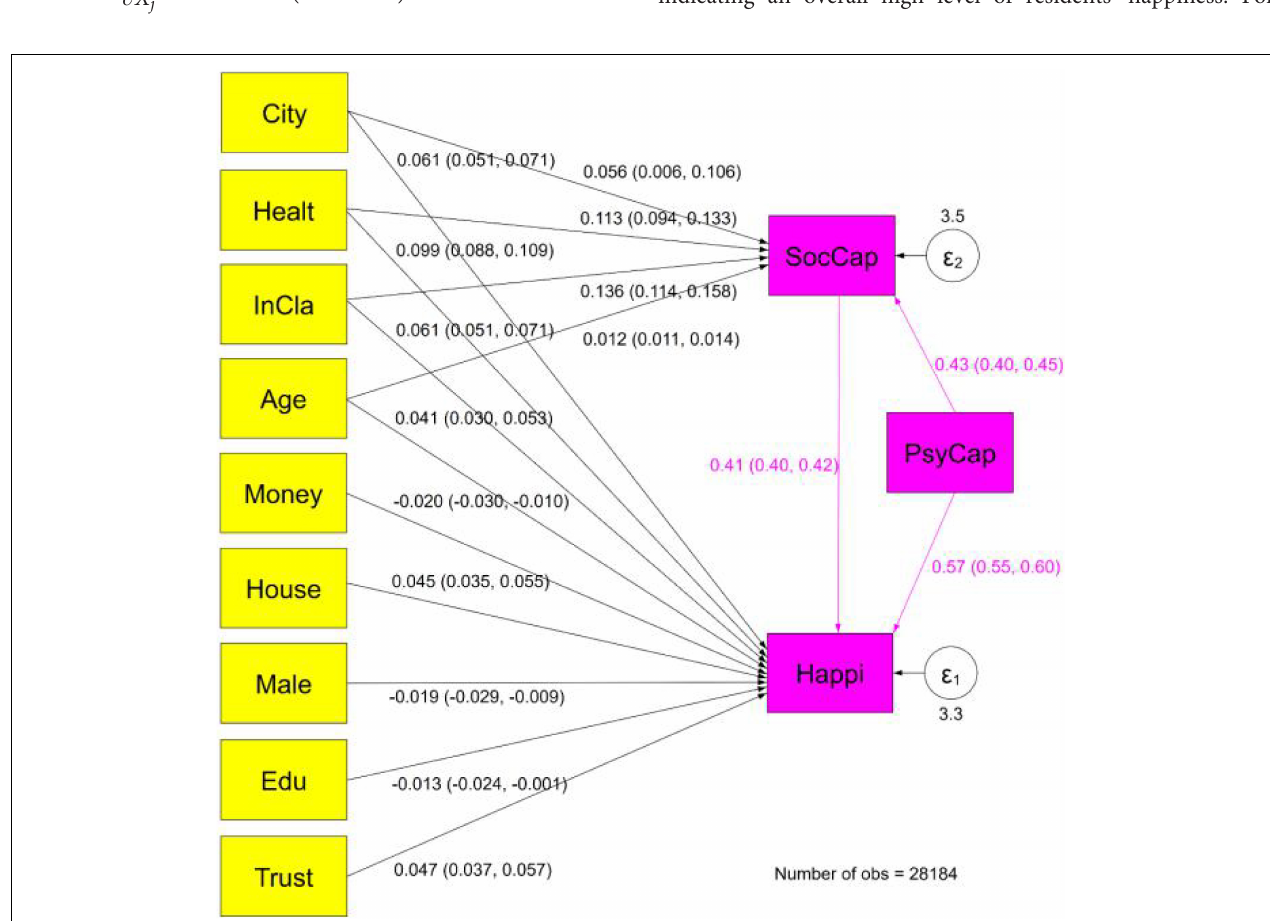
FIGURE 1 | Mediation effect estimation results. Standardized parameter estimates and confidence intervals are in